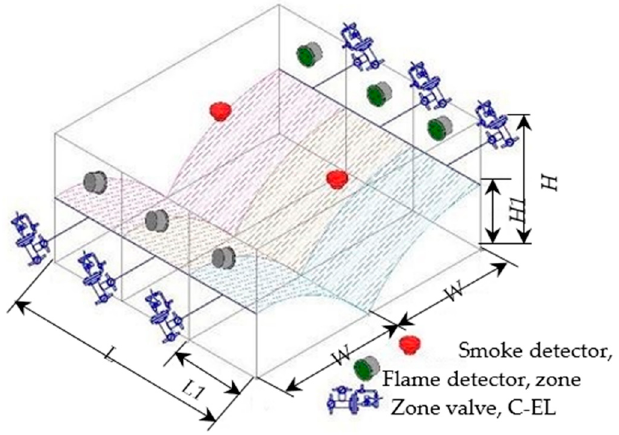
Figure 24. VID FireKill APS Atrium System general arrangement schematic [89].